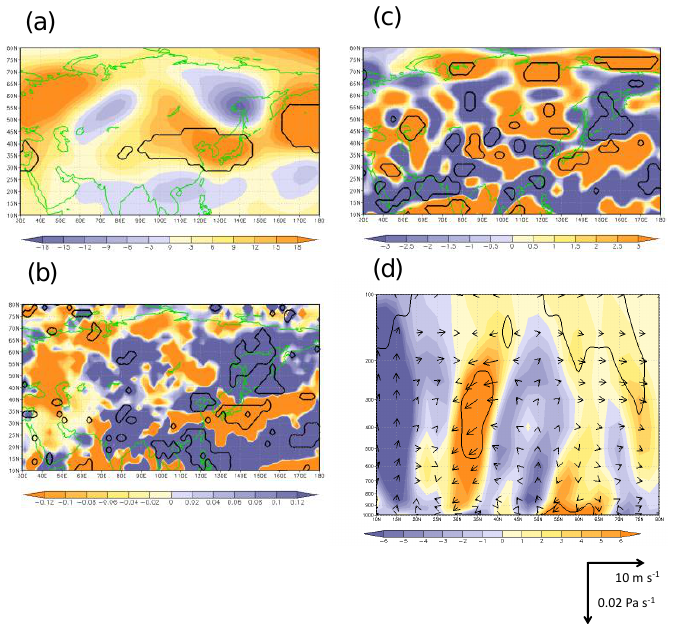
Figure 7. Composite differences in ( a ) geopotential height (in m) at 500 hPa, ( b ) precipitation (in mm day −1 ), and ( c ) vertical p-velocity (in 10 −3 Pa s −1 ) at 500 hPa between hot and cool summer years in WJ. ( d ) Latitude-pressure cross-section of the composite differences in vertical p-velocity (in 10 −3 Pa s −1 ) between hot and cool summer years in WJ at 140° E. Vectors show the composite differences in meridional-vertical flow (see legend for units). The borders of regions that reached a significance of 95% are shown with thick lines.